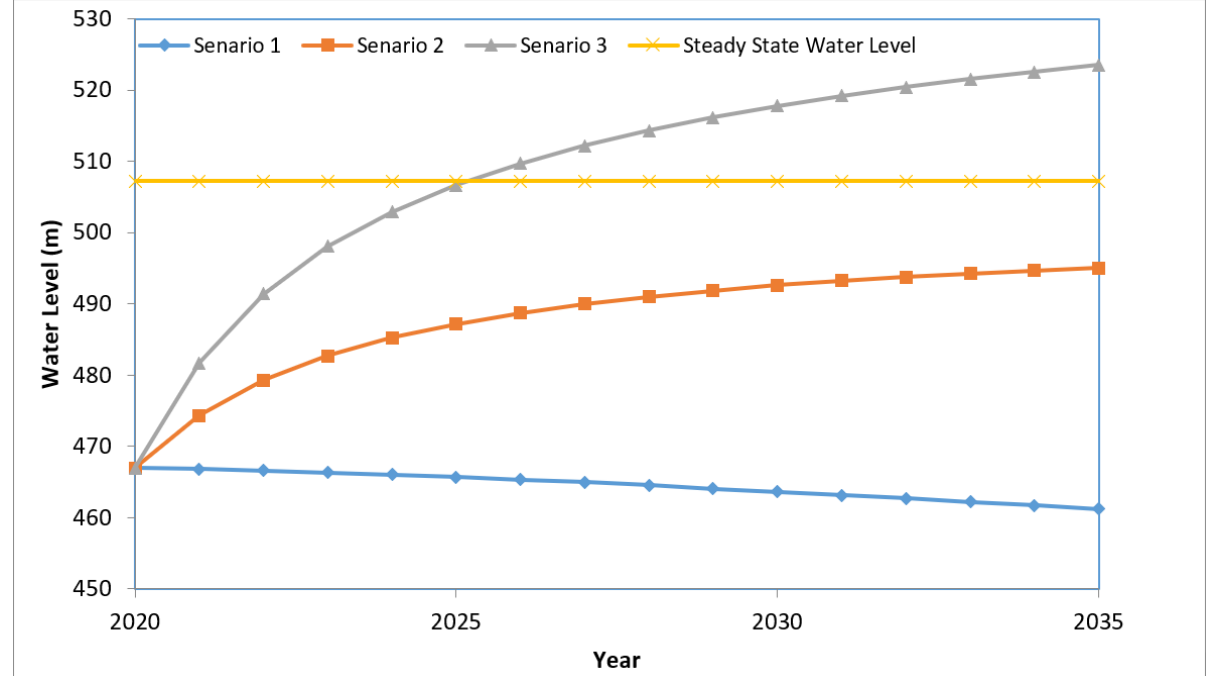
Figure 12. Model prediction for the three scenarios at the observation well (AL1043).